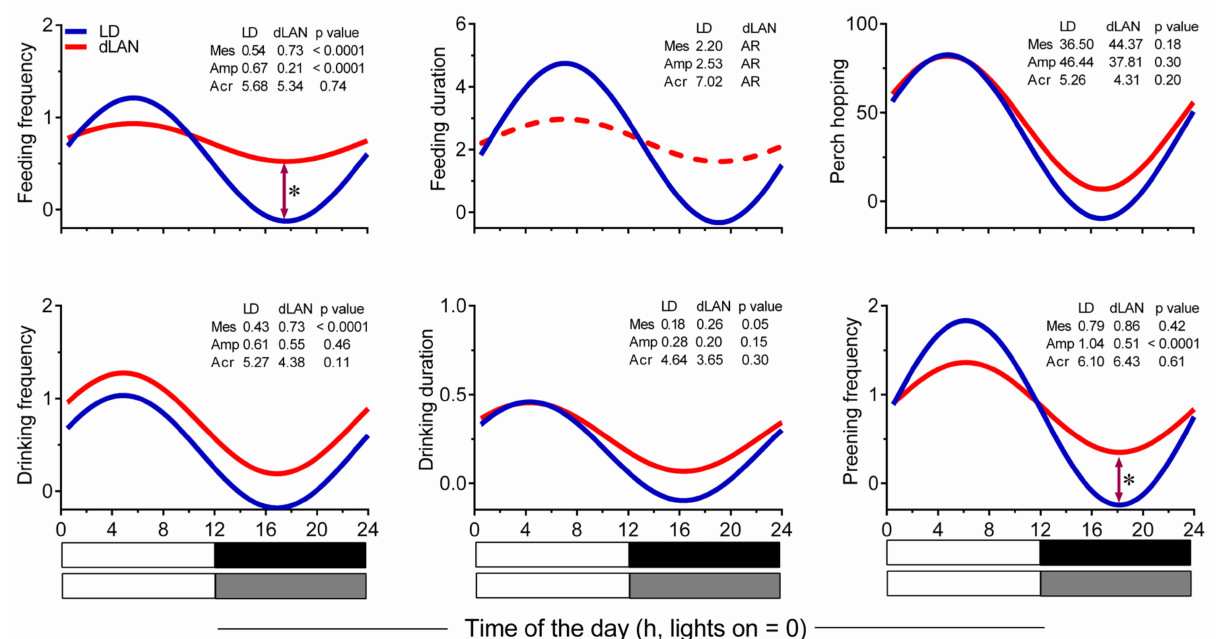
Figure 2. A non-linear regression rhythm plot of feeding, perch-hopping, drinking and preening behavior of adult male zebra finches ( Taeniopygia guttata ) under 12 h light: 12 h darkness (12L:12D) with absolute dark nights ((LD: L = 200 lux; D < 0.1 lux), and 12 h light: 12 h dim light at night (dLAN: L = 200 lux; D = 5 lux). The white bar represents light period and black and grey bar represents darkness (D) and dim light at night (dLAN) period, respectively. The solid and dotted line represents rhythmicity and arrhythmicity in behavior, respectively as determined by cosinor regression analysis. The waveform characteristics are defined as mesor (Mes), amplitude (Amp) and acrophase (Acr) of significant 24-h rhythmic behaviors. The F-test determined the difference between LD and dLAN parameters. The * symbol shows significance tested by Student’s t -test. For significance, alpha was set at